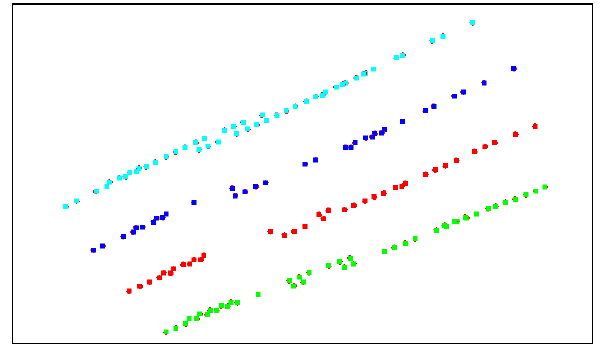
Figure 2: Point cloud of study area